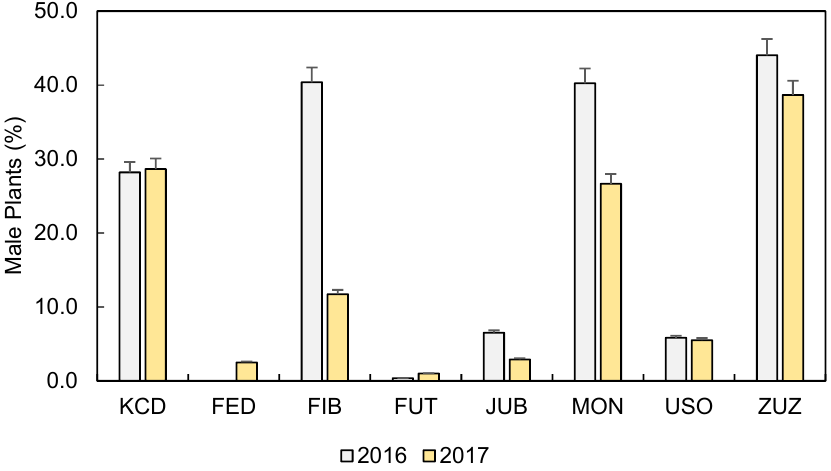
Figure 2. Presence of male plants. Data are means, error bars are standard deviations. (KCD = KC Dora; FED = Fedora 17; FIB = Fibrol; FUT = Futura 75; JUB = Jubileu; MON = Monoica; USO = Uso-31; ZUZ = Zuzana).